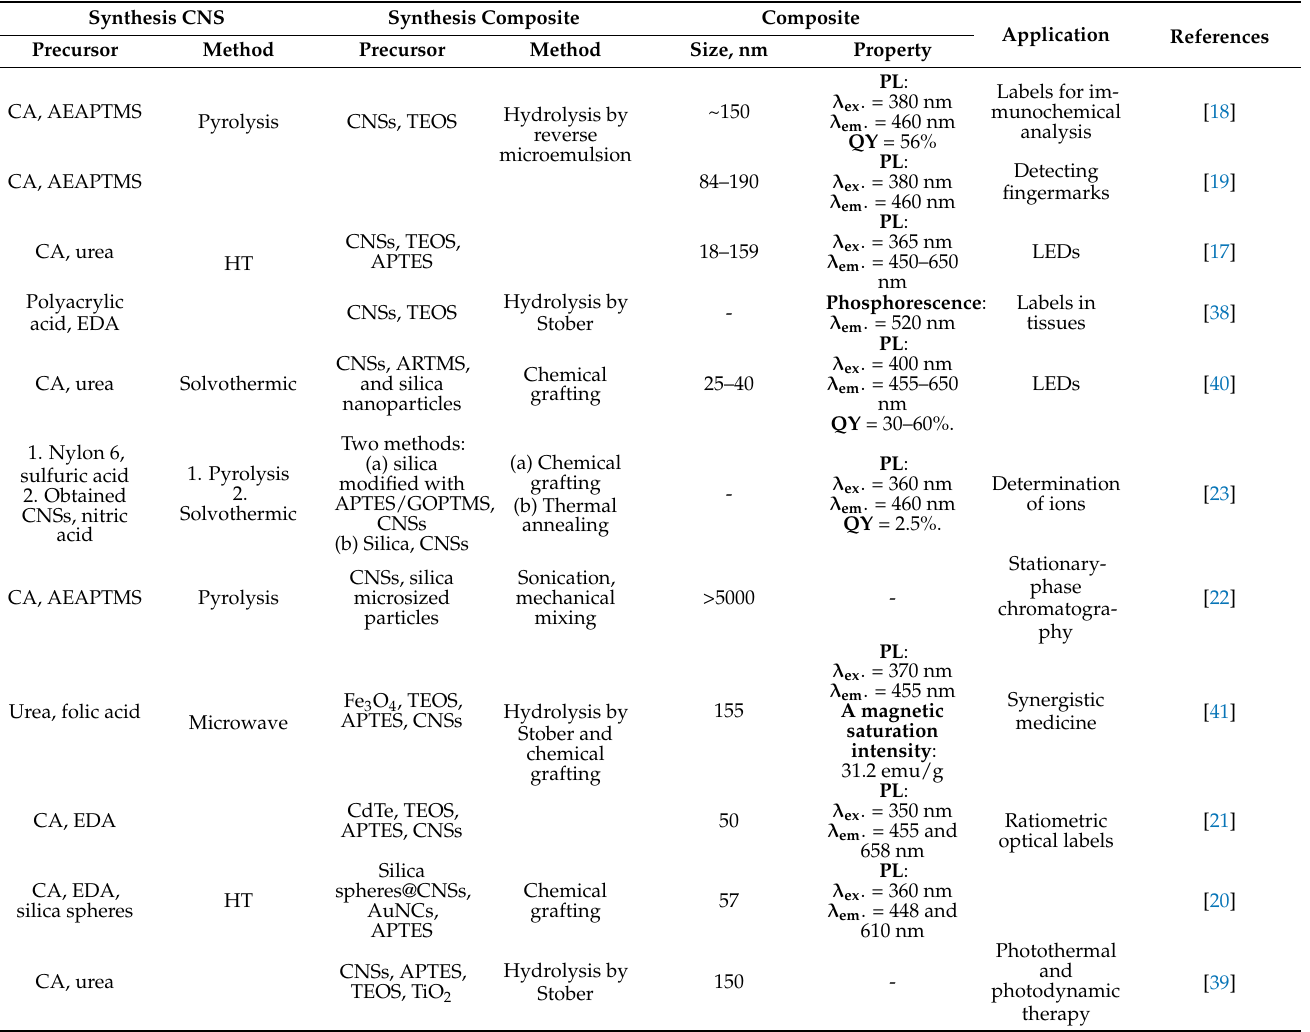
Table 1. Examples of CNSs/SiO 2 composites: synthesis, properties, and